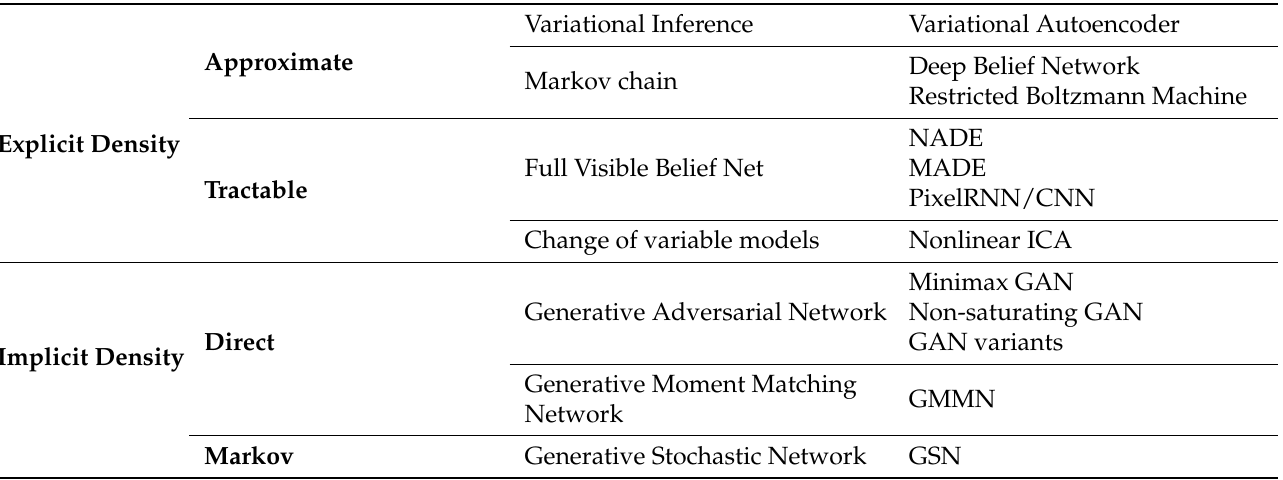
Table 1. Taxonomy of generative